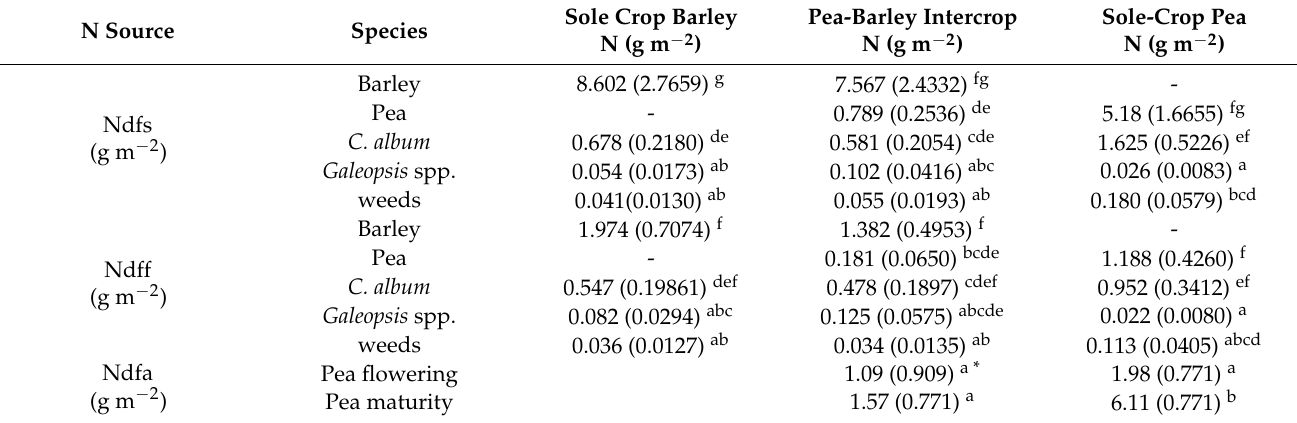
Table A4. Accumulated N derived from the soil (Ndfs) and fertilizer (Ndff) in the fertilized treatments of crops separated by species. Back-transformed means estimating medians and standard errors are presented for Ndfs and Ndff, which were obtained via the delta method. The original estimates based on ln-transformed data are presented in Table A5. Mean values of Ndfs and Ndff are averaged over sampling time (flowering, maturity; thereby n = 6) due to non-significance of this factor in the analysis of variance. Mean values of Ndfa are averaged over the factor N-level ( n = 6). Different letters within each group of N sources indicate significant different mean values following pairwise comparison with Tukey adjustment ( α = 0.05).* One plot (fertilized intercrop at flowering) had to be removed from analyses due to missing N analysis.